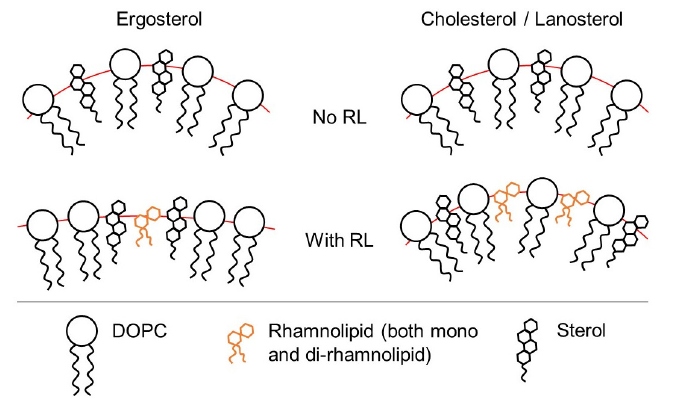
Figure 10. A possible model for the incorporation of rhamnolipid molecules with a model DOPC membrane depending on the sterol composition of the